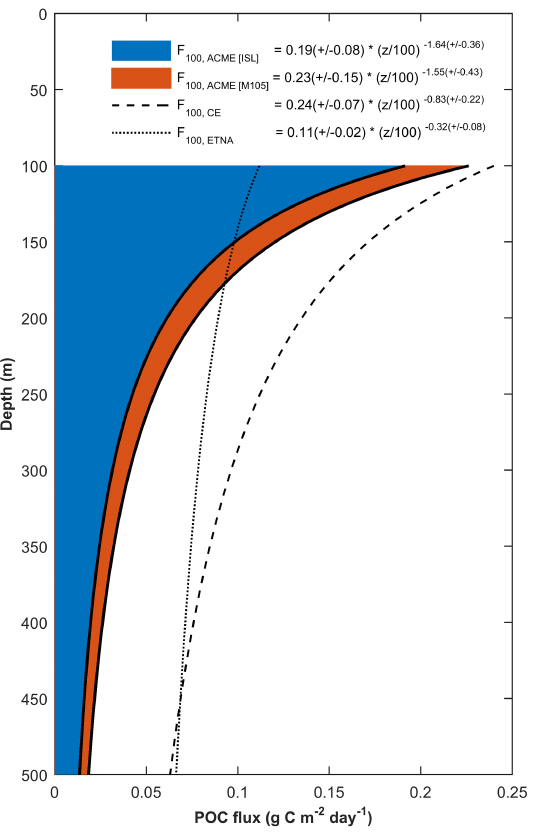
Figure 8. Derived downward POC fluxes based on a model af- ter (Martin et al., 1987b) for the two ACME surveys (blue and red), a cyclonic eddy sampled by an Argo float (CE, dashed line; Karstensen et al., 2015) and the general ETNA (Karstensen et al., 2008). Flux estimates for the two ACME surveys are based on CRRs estimated from DIC sample data. For the CE, aOURs derived from oxygen measurements on an Argo float were converted to CRRs by applying a stoichiometric O 2 :C ratio of 1.34 (Körtzinger et al., 2001b). Background POC flux in the ETNA was estimated from large-scale thermocline aOURs derived from transient tracer data and AOU (Karstensen et al., 2008) followed by a stoichiometric conversion as described